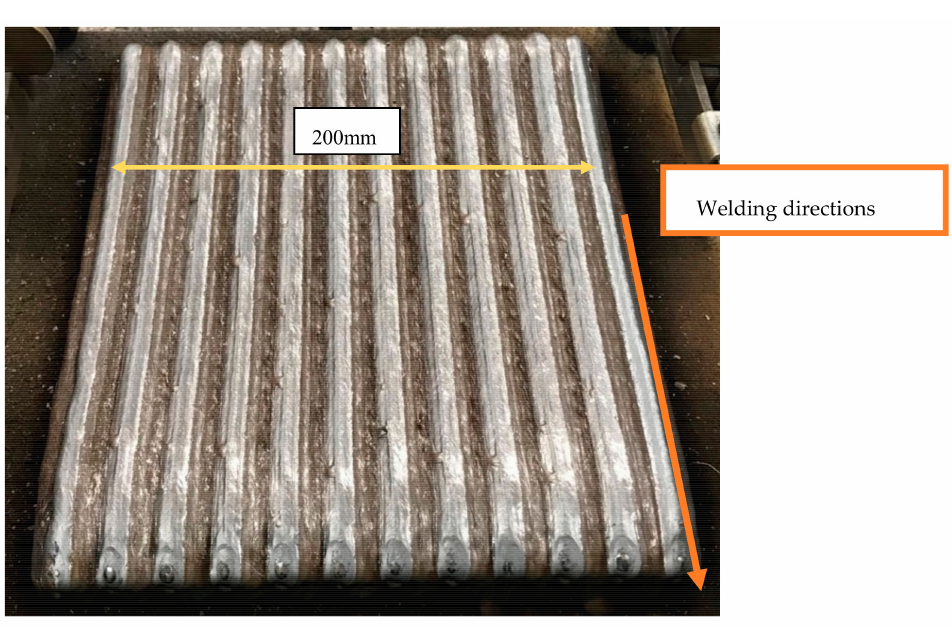
Figure 2. Welded test